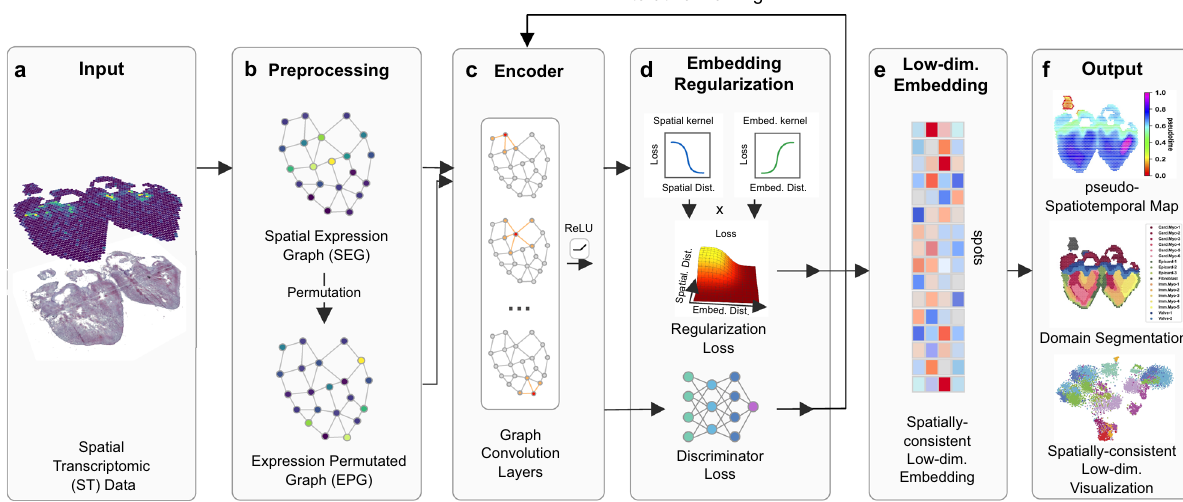
Fig. 1 Overview of SpaceFlow. a The input ST dataset consist of an expression count matrix and spatial coordinates of spots/cells. b A spatial expression graph (SEG) is constructed as the network input, with edges characterizing the spatial neighborhood, and nodes representing cells/spots with expression pro fi les attached. By randomly permuting the nodes in SEG, Expression Permuted Graphs (EPG) are built as negative samples. c A two-layer GCN encodes the SEG or EPG input into low-dimensional embeddings. d The embeddings are regularized for spatial consistency. With the Spatial Regularization loss and the Discriminator loss, the encoder is iteratively trained until convergence. e The low-dimensional embedding is obtained from the trained encoder. f The output consists of the pseudo-Spatiotemporal Map (pSM), domain segmentation, and the visualization of low-dimensional